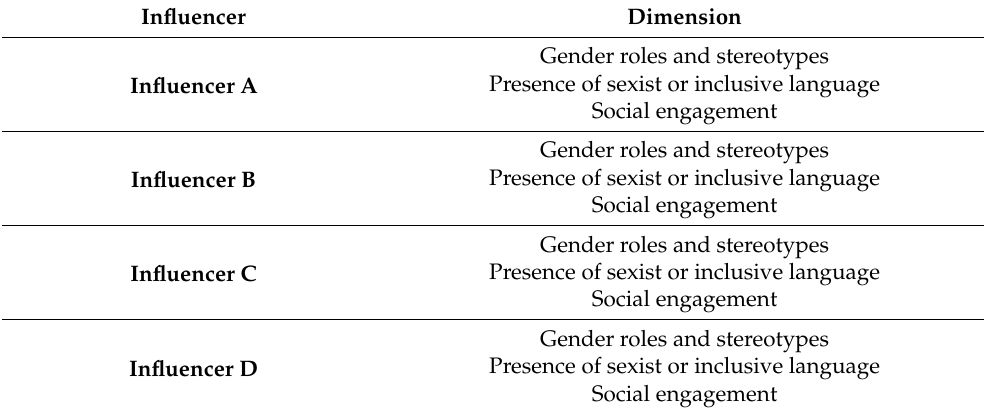
Table 1. Instagram and YouTube